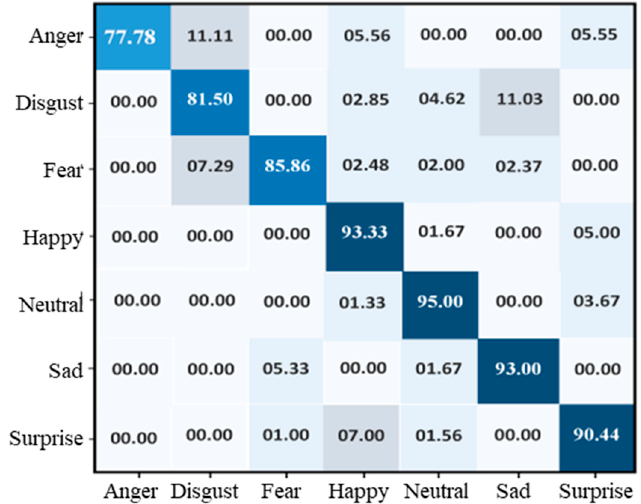
Figure 4. Confusion matrix of the proposed model over the FER-2013 dataset.